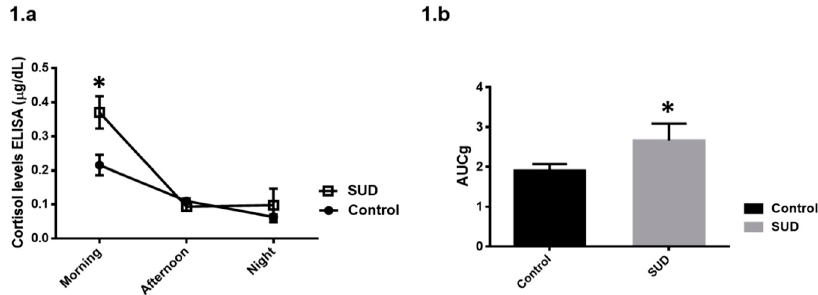
Figure 1. ( a ) Comparison between groups in basal salivary cortisol at three-day moments ( μ g/dL). As group (* p ≤ 0.05). ( b ) Area under the curve with respect to ground (AUCg) index reflecting an